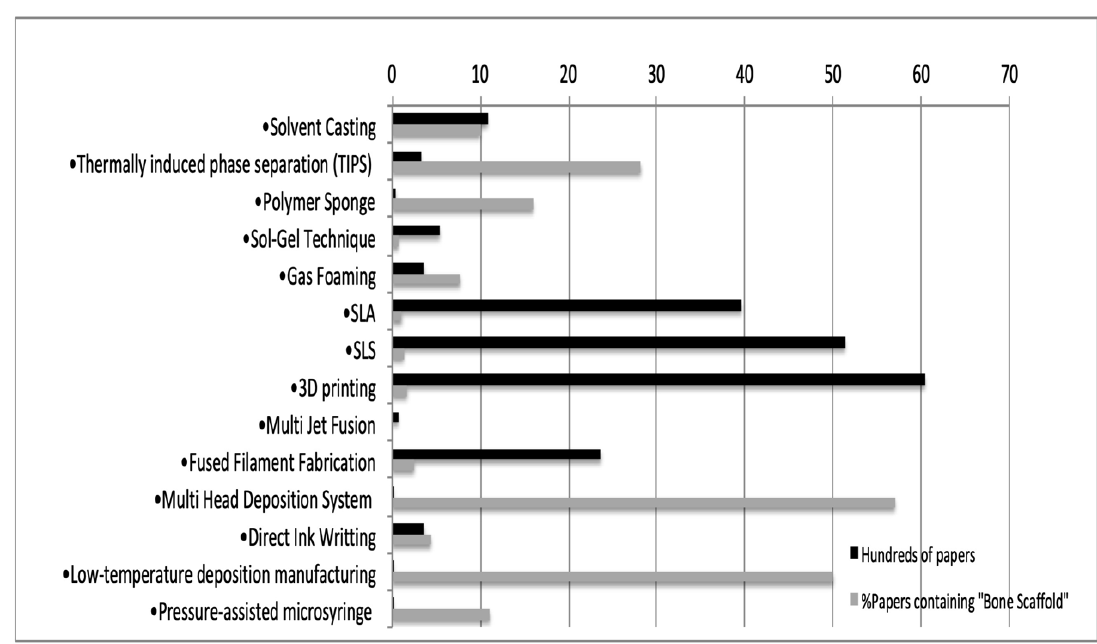
Figure 3. Scientific support of each of the 14 techniques identified as potentially in force regarding the raw number of papers and the percentage of papers containing “bone scaffold”.